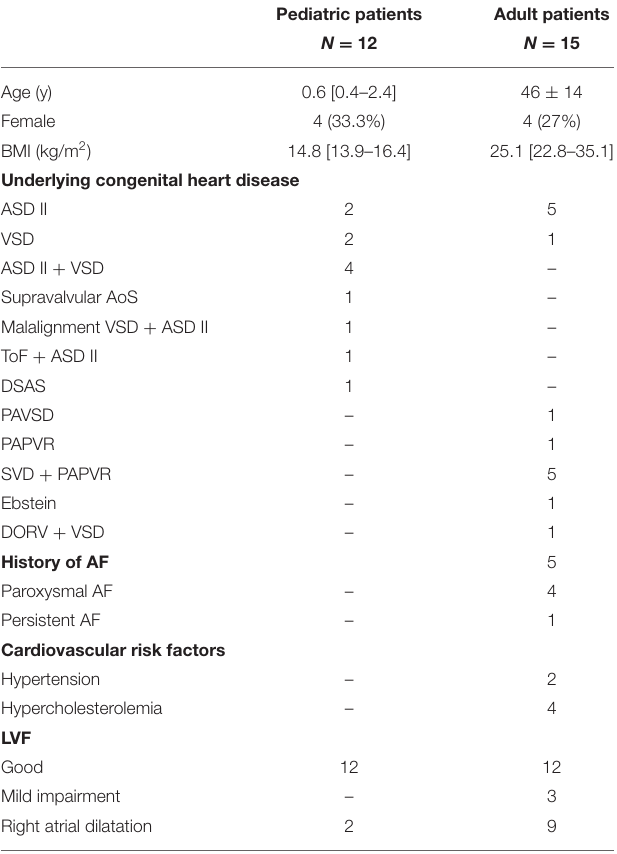
TABLE 1 | Patient characteristics.